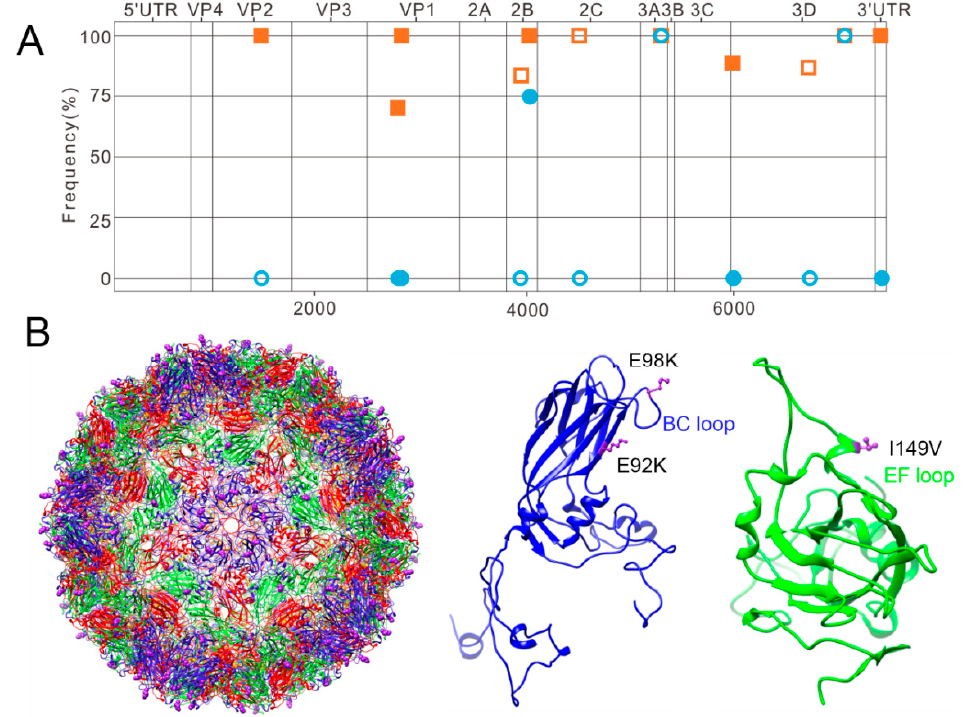
Figure 2. Adaptive mutations in the GZCII-P30 genome revealed by Next-Generation Sequencing were mapped onto the EV71 capsid. ( A ) Genomic RNA of the GZCII and GZCII-P30 viruses was sequenced by NGS, and the mutation frequency and distribution were analyzed according to the reference sequence (cGZCII). The open symbols represent nonsynonymous mutations, and the closed symbols are synonymous mutations. Red: GZCII-P30; Blue: GZCII. ( B ) A 3D structure of the GZCII-P30 virus was predicted by SWISS-MODEL homology modeling based on PDB:3VBF.1. VP1-E92K and E98K reside at the 5-fold axis, while VP2-I149V is located in the E-F loop on VP2. Blue: VP1; red, VP2; green, VP3; yellow, VP4.